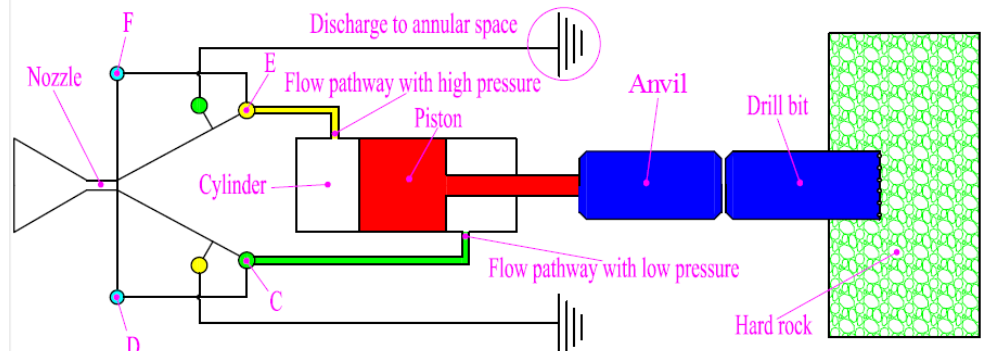
Figure 2: Schematic diagram of a hydraulic hammer with the horizontal anvil. C, E: Discharge channel; D, F: Controlled flow channel The pumped mud with high pressure and velocity was initially delivered to the nozzle through the drilling pipe, which is termed as the pressure inlet. Then the mud is sprayed by the nozzle to generate a wall-attachment effect with high mud speed. It has been provided that the mud is attached to the back chamber (as shown in yellow pipe line), thus the piston then is actuated by high pressure mud to horizontally impact the drill bit. In the meantime, the controlled channel F is stimulated by a pressure pulse while the piston with the anvil moves to the right dead point, simultaneously the discharge channel of high pressure mud is shifted from channel E to channel C, and the mud is instantaneously pumped into the ante-chamber of the cylinder (as shown in green pipe line), which actuates the piston to move back to return strokes. The whole working process of the hydraulic hammer rapidly and periodically completes in hundreds of a second. Therefore, and back